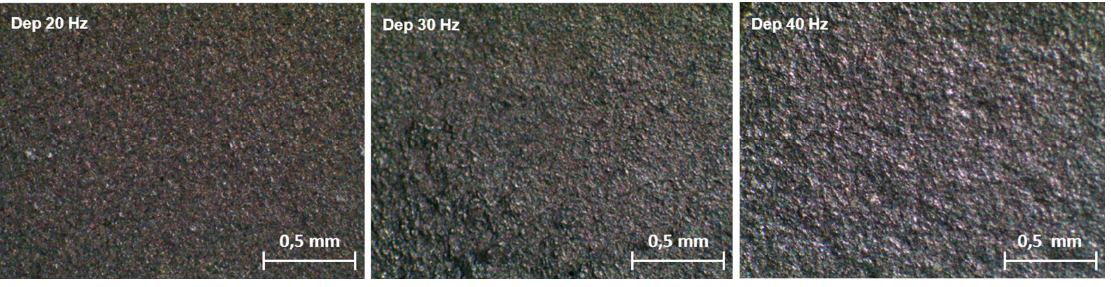
Figure 2. Stereoscope images of films formed at 20 Hz, 30 Hz, and 40 Hz.